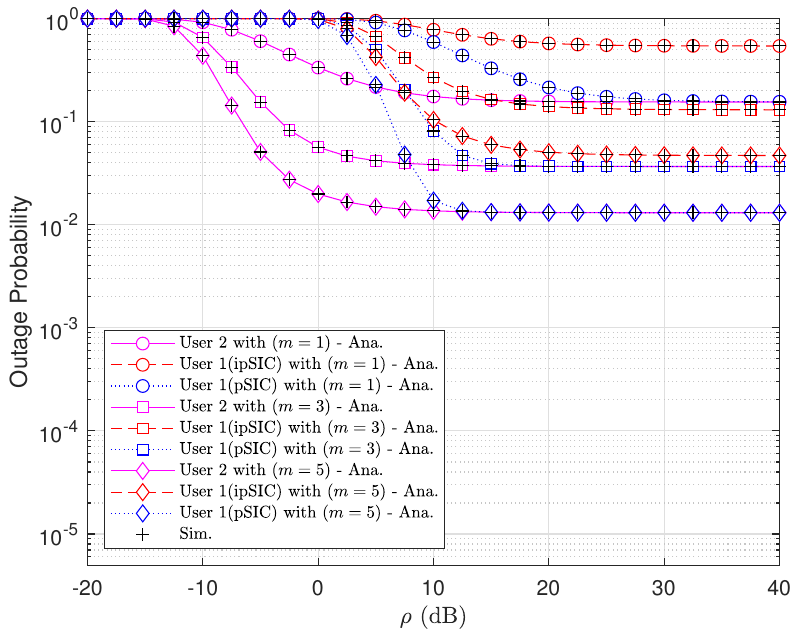
Figure 3. Outage probability obtained for various fading parameters m with N = K = 3.